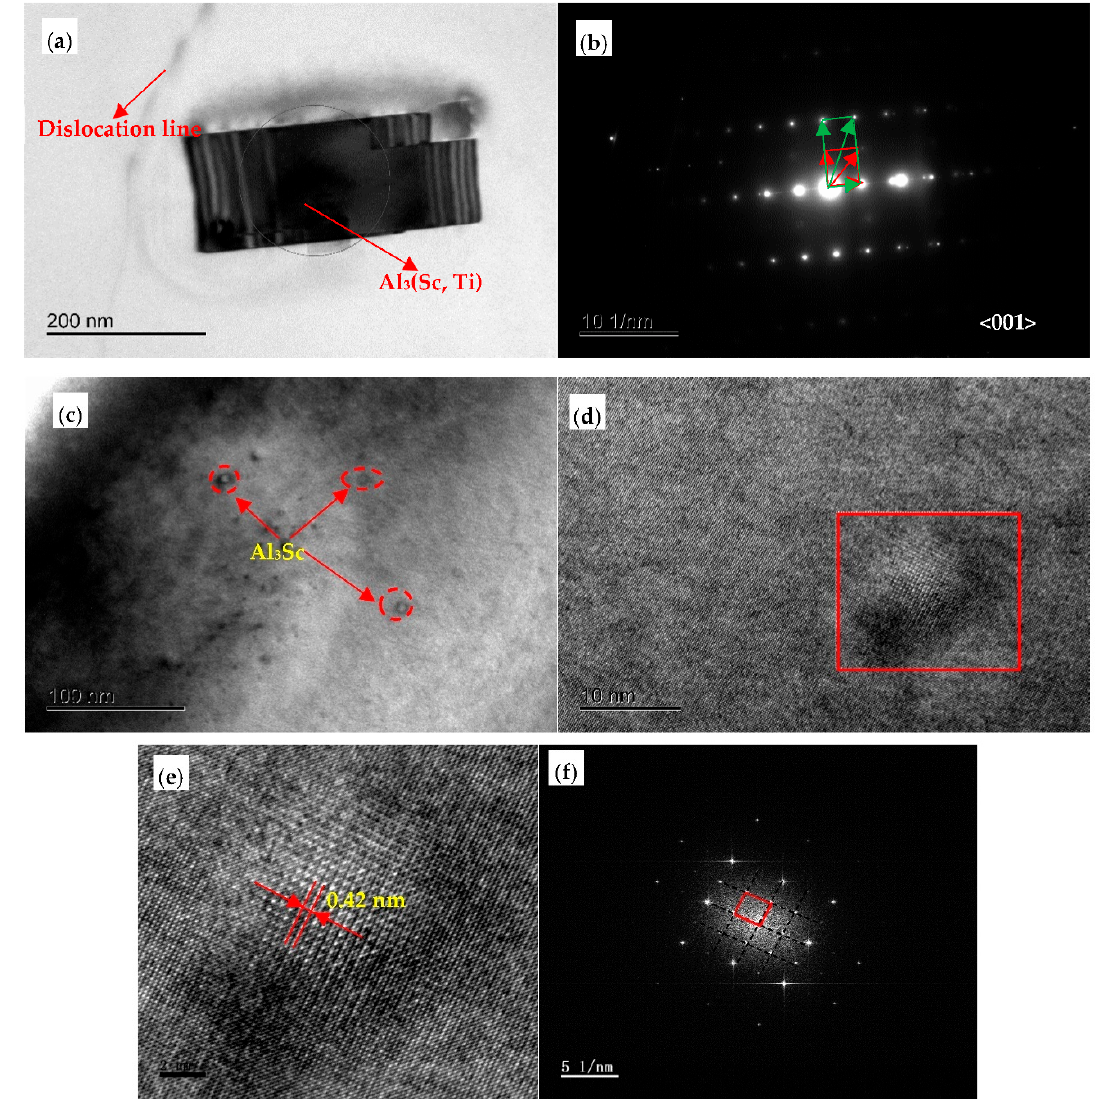
Figure 6. Microstructure TEM images of Al-Mg Alloy with Sc: ( a ) bright field image of Al 3 (Sc, Ti) phase; ( b ) Al 3 (Sc, Ti) phase diffraction pattern along the <001> crystallographic direction of Al matrix; ( c ) bright field image of Al 3 Sc phase; ( d ) Al-Mg alloy high-resolution image; ( e ) high-resolution image of Al 3 Sc phase; ( f ) FFT of ( e ).